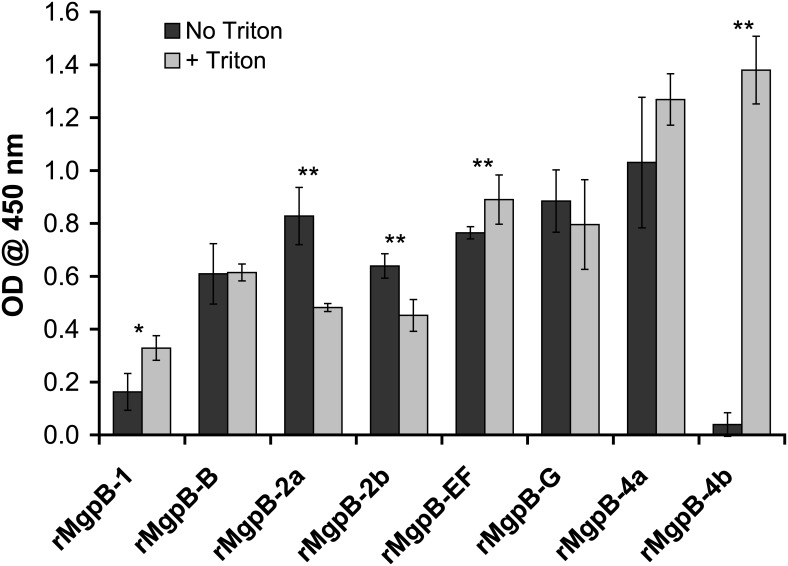
The Majority of MgpB-Reactive Antibodies Bind to the Surface of Intact M. genitalium Cells.Binding of region-specific antibodies to MgpB was measured using intact (PBS-treated, “No Triton” dark gray) and Triton X-100 permeabilized (“+ Triton”, light gray) M. genitalium. The increased reactivity with treated compared to untreated cells was significant for the conserved N-terminus (rMgpB-1; *, p = 0.024), variable region EF (rMgpB-EF; **, p < 0.001), and the putative cytoplasmic domain (rMgpB-4b; **, p = 0.0004); conversely there was a significant decrease in antibody binding in treated compared to untreated cells for the second conserved region (**, p = 0.007 and p = 0.0061 for rMgpB-2a and -2b, respectively). The assay was repeated in triplicate with results of a typical experiment shown above with each condition tested in quadruplicate; error bars indicate standard deviation.